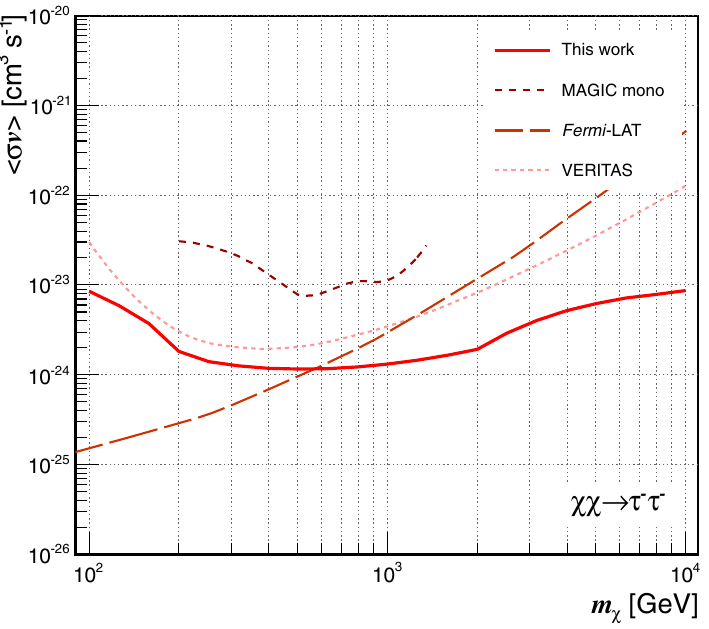
Figure 6. Upper limits on (cid:4) (cid:4) ann v (cid:5) for the final state channels (cid:3) + (cid:3) − from the Segue 1 observations with MAGIC (solid lines), compared with the exclusion curves from Fermi -LAT (long-dashed lines), H.E.S.S. (dot-dashed line), VERITAS (dotted lines) and MAGIC-I (dashed